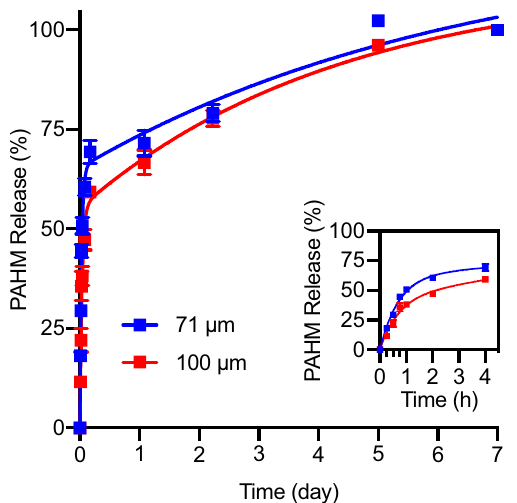
Figure 5. Release kinetics of PAHM from coated embolic microspheres in cell culture medium at 37 °C. Data are shown as mean ± SD (n = 4) and are fit with a two-phase exponential association